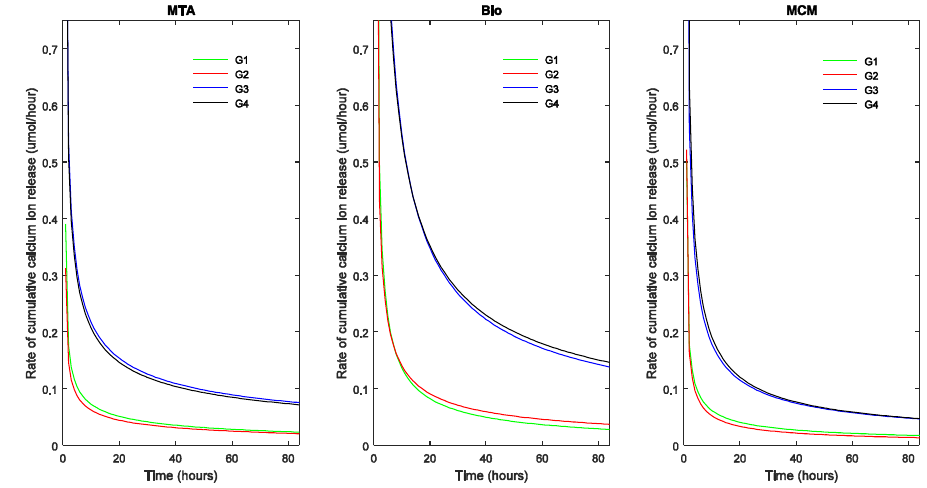
Figure 5. Cumulative calcium ion release rate of the TSCs studied as a function of sample dimensions.